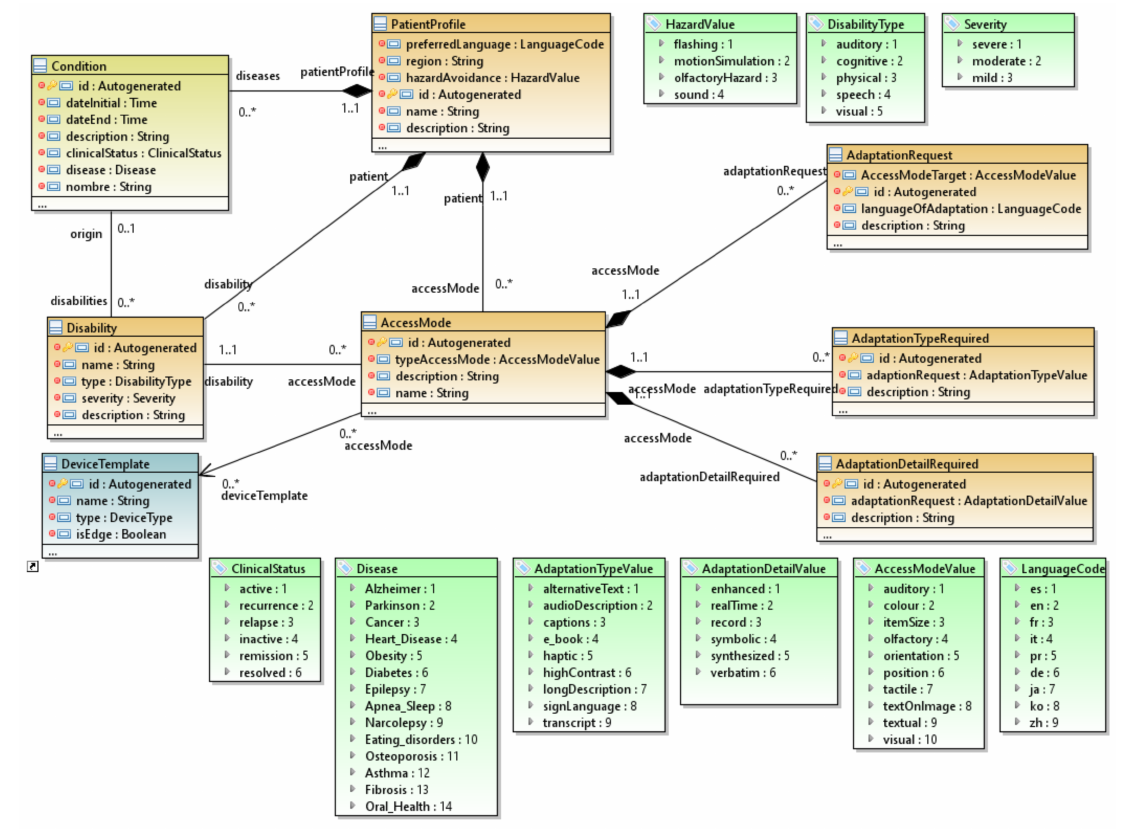
Figure 3. The patient profile